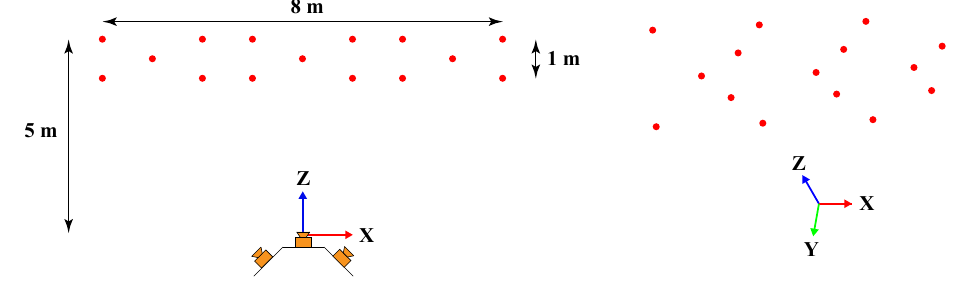
Figure 8. Setup of measurement error